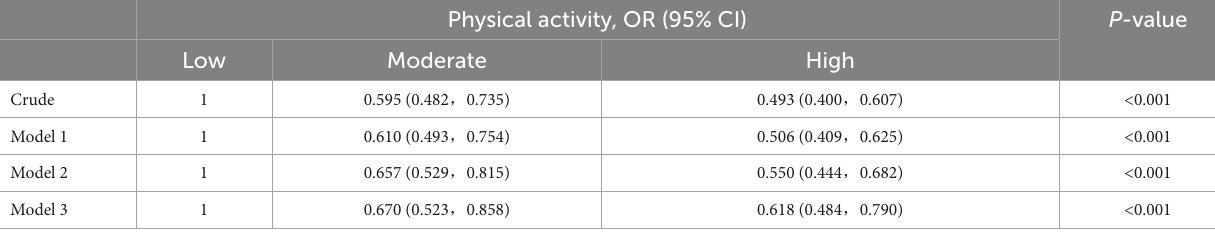
TABLE 2 Association of physical activity levels with depression.